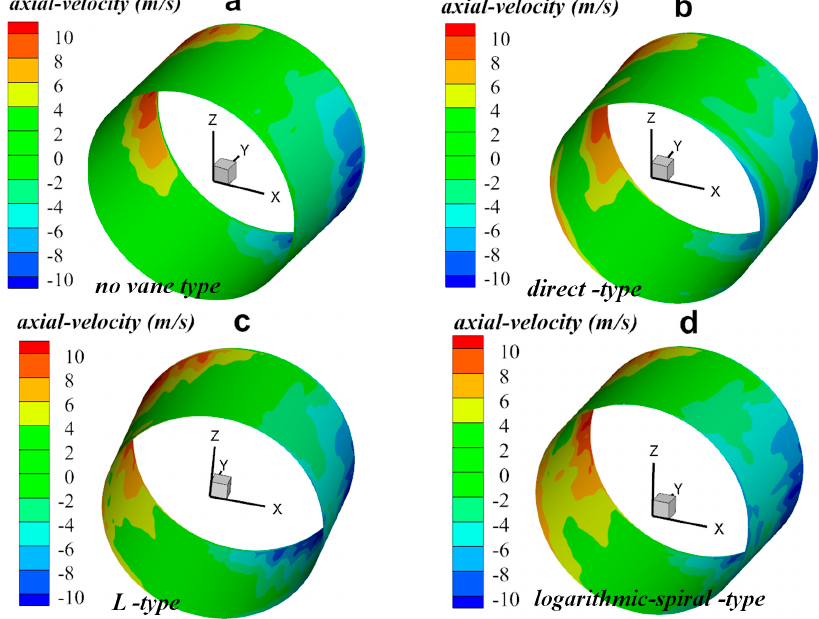
Figure 9. Comparison of the axial velocity distribution of rotor cage by four different guide vanes. ( a ) no vane type; ( b ) direct-type; ( c ) L-type; ( d ) logarithmic-spiral-type.